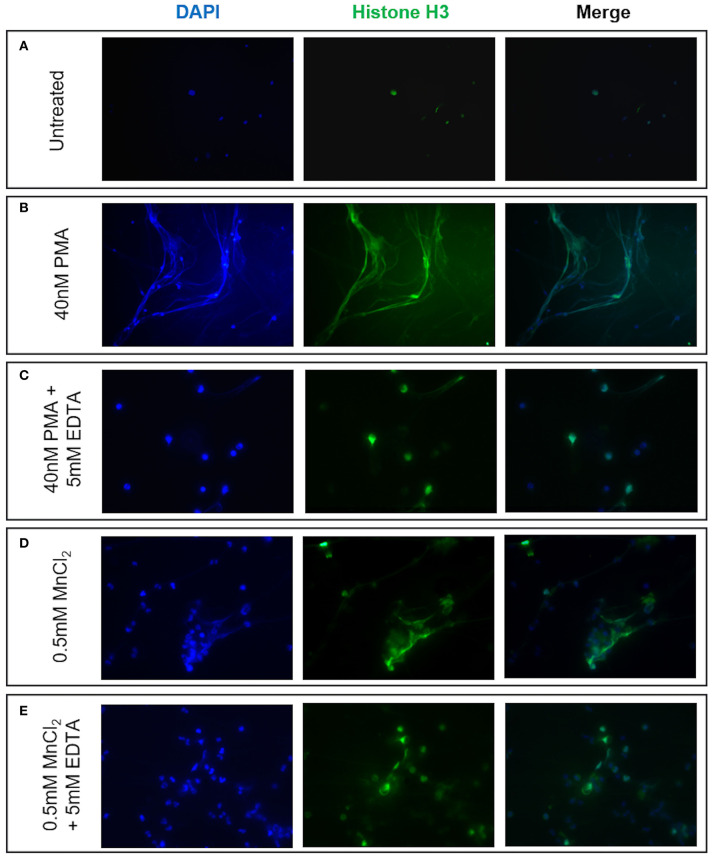
NET formation can be induced by neutrophil integrin activation. The effects of cation-dependent integrin activation upon NET release was examined visually by immunofluorescence staining of both nuclear DNA (DAPI, blue staining) and histone H3 (green staining). (A) Untreated neutrophils displayed punctate nuclear staining. (B) 40 nM PMA stimulation induced DNA and histone externalization. (C) PMA-induced NET release could be mitigated by the addition of 5 mM EDTA (cation chelator). We subsequently examined whether cation-dependent integrin activation could induce NETs. (D) Stimulation with 0.5 mM MnCl2 induced some DNA externalization. (E) DNA externalization was suppressed following cation chelation with EDTA. Representative images are shown from three independent experiments.